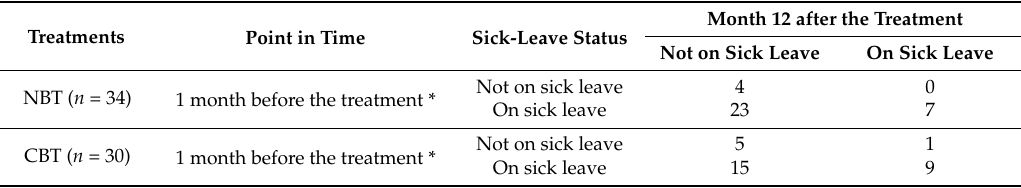
Table 3. Number of contacts with a general practitioner from twelve months before treatment to twelve months after treatment (NBT: n = 37; CBT: n =